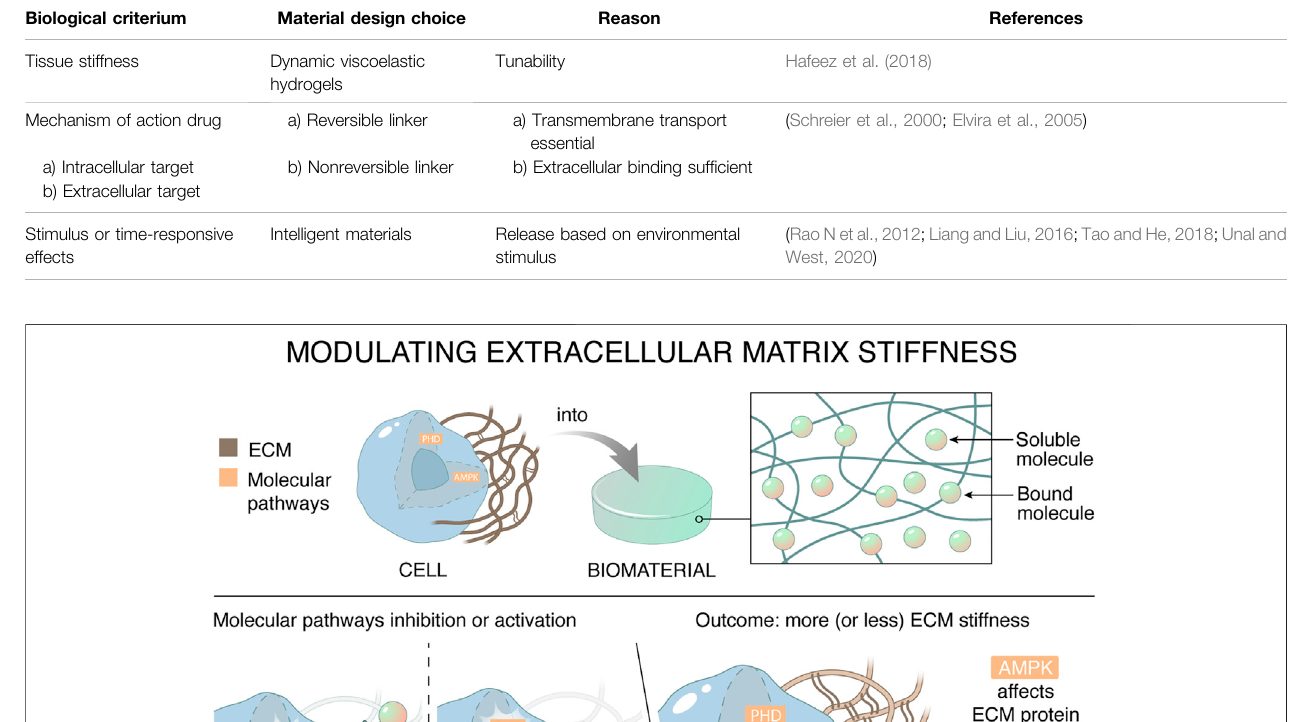
Frontiers in Bioengineering and Biotechnology |